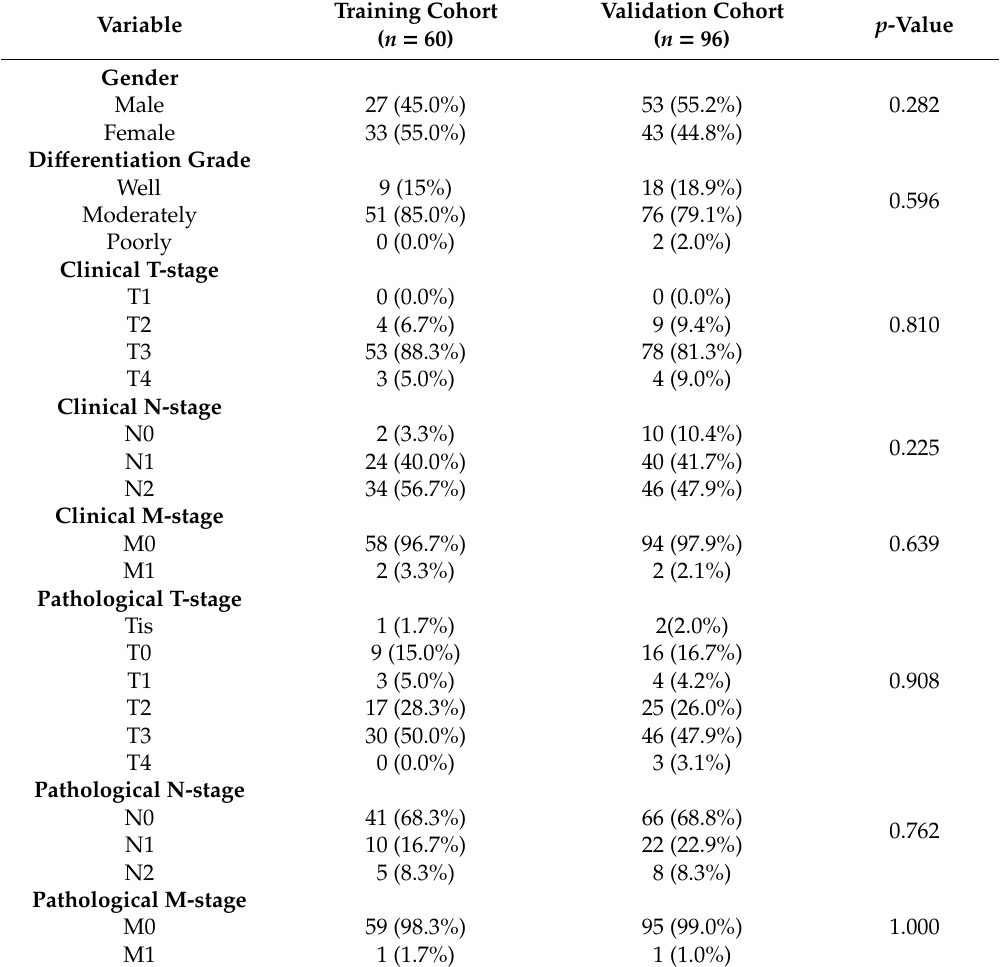
Table 1. Clinicopathological features of patients in the training and validation